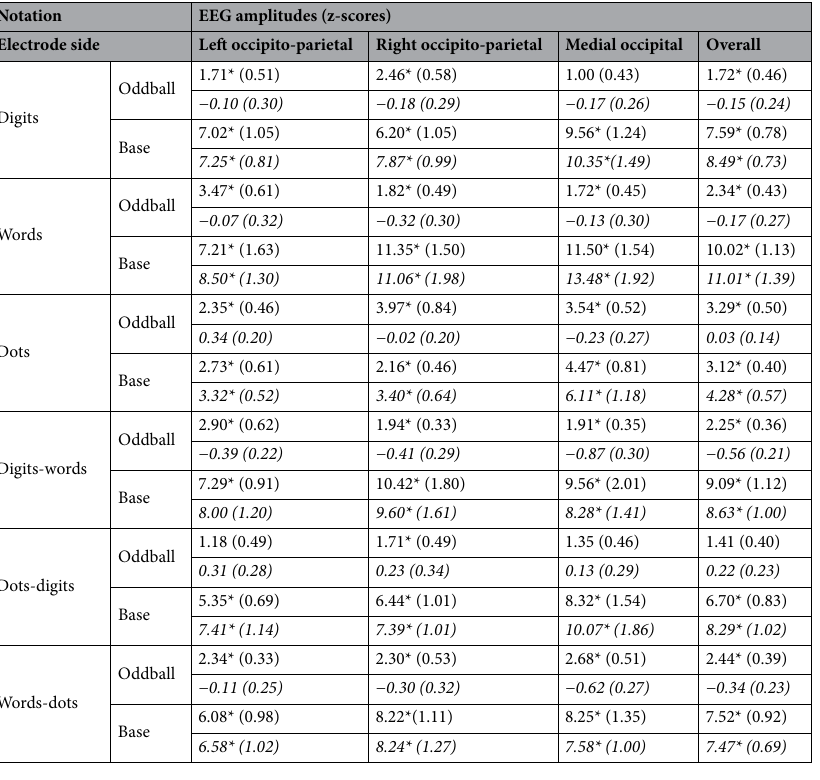
Table 1. Averaged z-scores (with the corresponding standard error (SE) of the mean) for the oddball and base frequencies, depicted per condition, notation, and electrode side. Significant z-scores (> 1.64) are marked with *. Control conditions are in